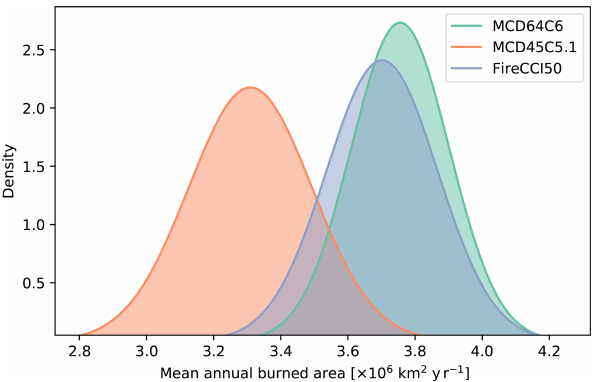
Figure 11. Constraints on global mean annual burned area (km 2 yr − 1 ) provided by the three